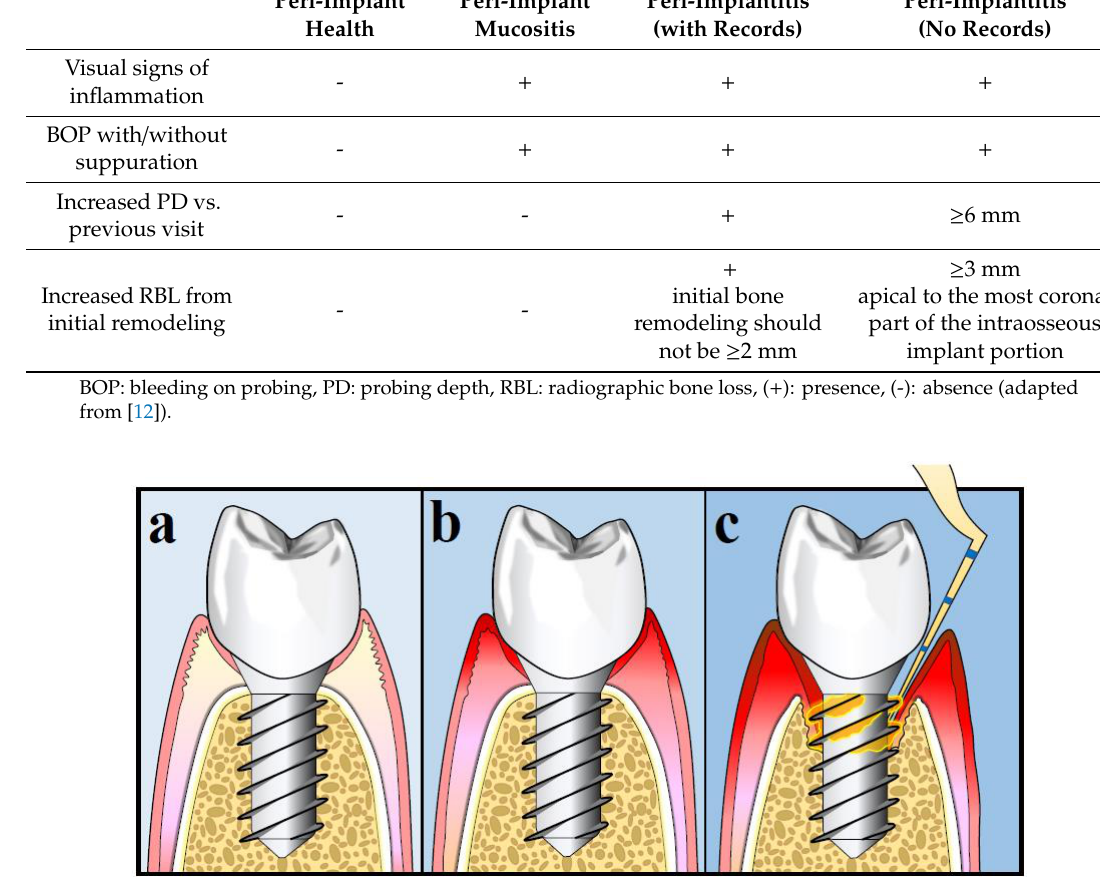
Figure 1. Peri-implant health/disease status: ( a ) Peri-implant health; ( b ) Peri-implant mucositis; ( c ) Peri-implantitis.